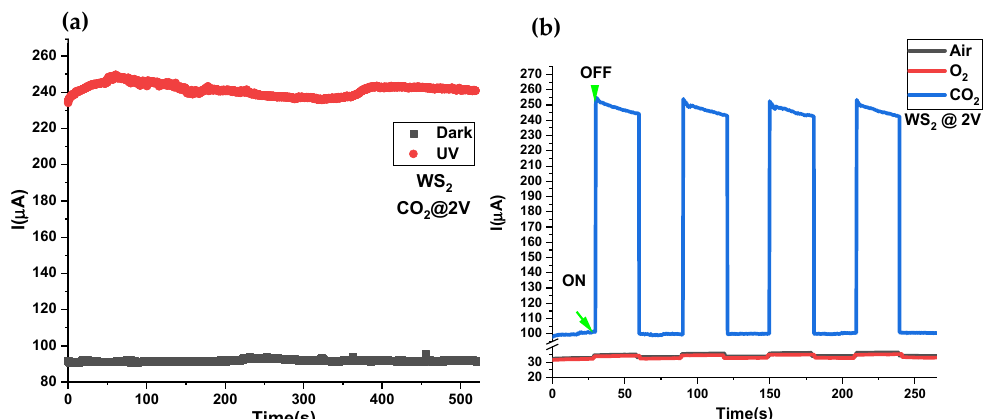
Figure 13. ( a ) Photocurrent behavior with time of WS 2 thin film under dark and UV conditions in CO 2 at a bias voltage of 2 V. ( b ) The on–off dynamics of the photoresponse with a time of WS 2 thin film in air, 50 sccm O 2 , and 50 sccm CO 2 environments under a bias voltage of 2 V.